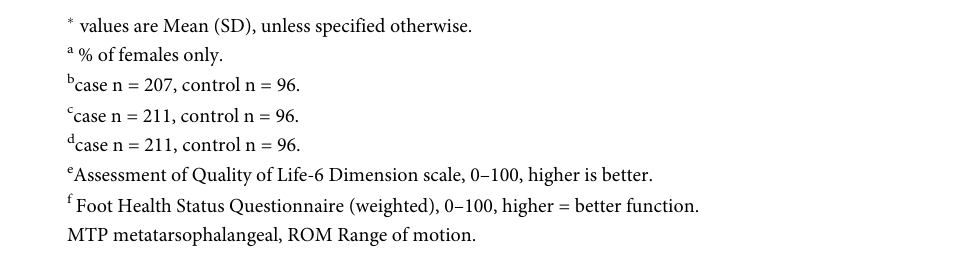
Univariable associations of CPHP and other factors with bone outcomes are given in Table 3, with those associations having P < 0.05 indicated in bold. Having CPHP was associated with higher trabecular density, BV/TV and trabecular thickness and lower trabecular separa- tion in the plantar ROI but was not associated with any mid-calcaneal bone outcome ( Table 3, all p < 0.05, ranging from 0.012 to 0.041) . At both ROIs, BMI and ankle plantarflexor strength were positively associated with trabecular bone density, BV/TV and thickness, negatively asso- ciated with trabecular separation, and positively associated with trabecular number except for ankle plantarflexor strength at the mid-calcaneal ROI. Female sex was negatively associated with all bone outcomes at both ROIs except for a positive association with trabecular separa- tion, and no association with trabecular thickness. Age was negatively associated with trabecu- lar density, BV/TV and thickness outcomes in the mid-calcaneum. In the plantar region age